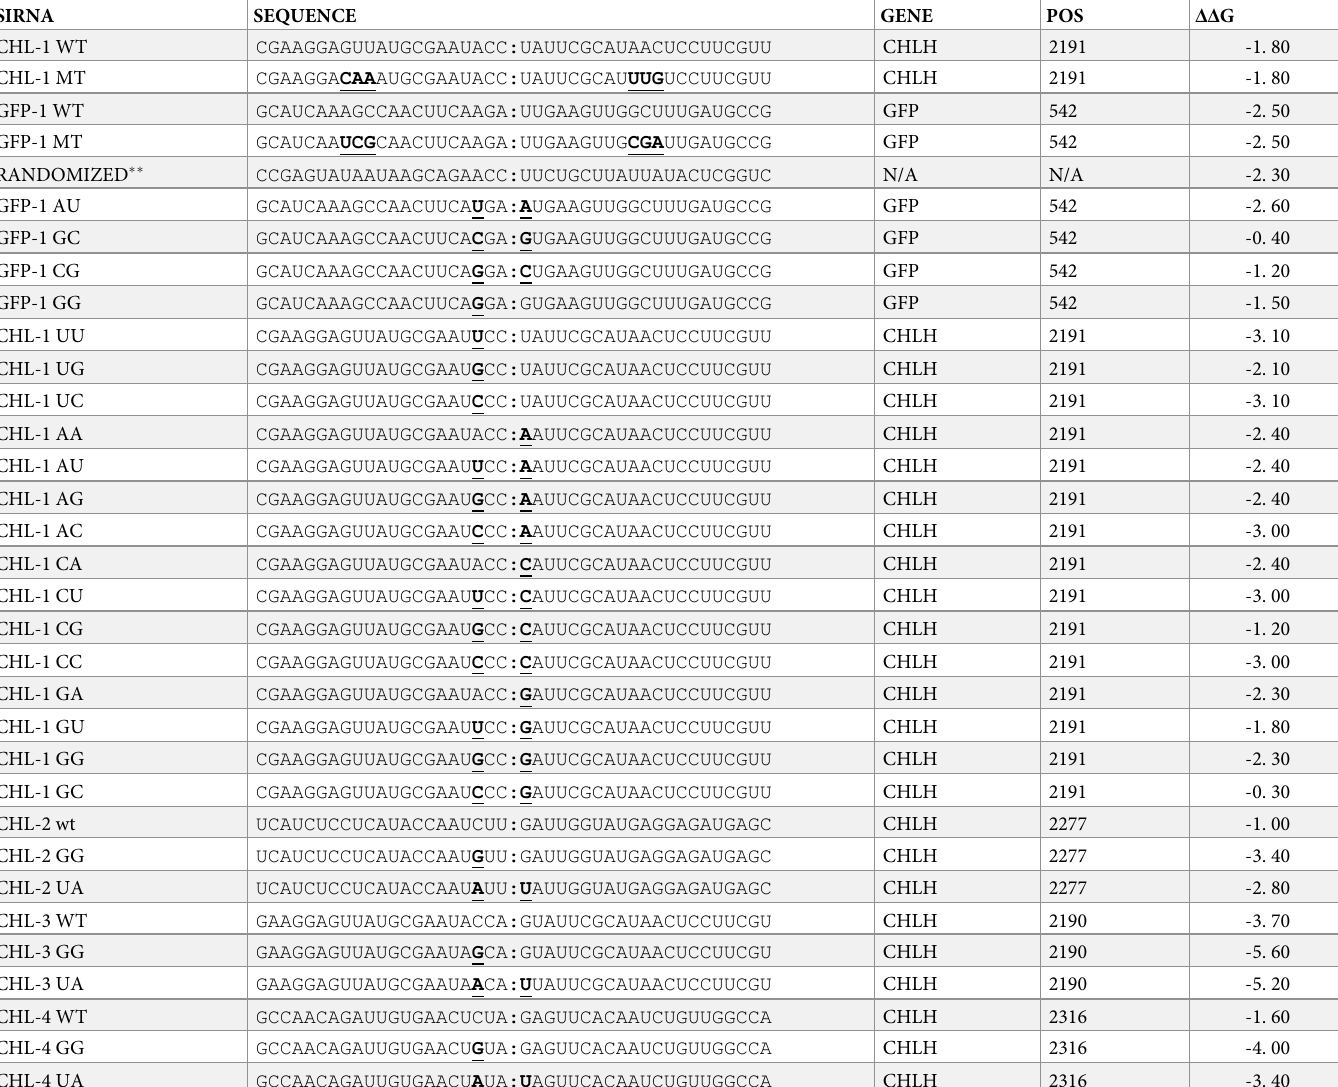
Table 1. Summary of all the siRNA sequences with their locations and the targeted genes, with the calculated ΔΔ G. siRNA are written as 5’ - > 3’ sense strand: 5’- > 3’ antisense strand. The bold and underlined letters denote non-native nucleotides. Pos, Position on the cDNA. SIRNA